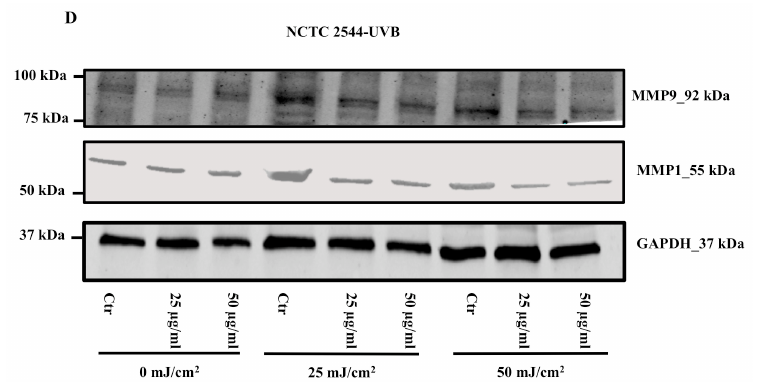
Figure 9. Effects of C. sinensis extract pretreatment (25 and 50 µ g/mL) for 4 h on the regulation of ( A ) the mRNA expression of MMP1 and MMP9; ( B , C ) protein levels of MMP1 and MMP9 after exposure to UVB (25 and 50 mJ/cm 2 ) in NCTC 2544 cells. ( D ) Representative immunoblotting image of each protein examined. The data are reported as the mean ± S.D. from two experiments performed in quadruplicates. Dashes to the right of the membrane bands show positions of prestained molecular mass marker. ** Significant vs. untreated control cells: p < 0.01; *** Significant vs. untreated control cells: p < 0.001; # Significant vs. untreated irradiated cells: p < 0.05; ## Significant vs. untreated irradiated cells: p <